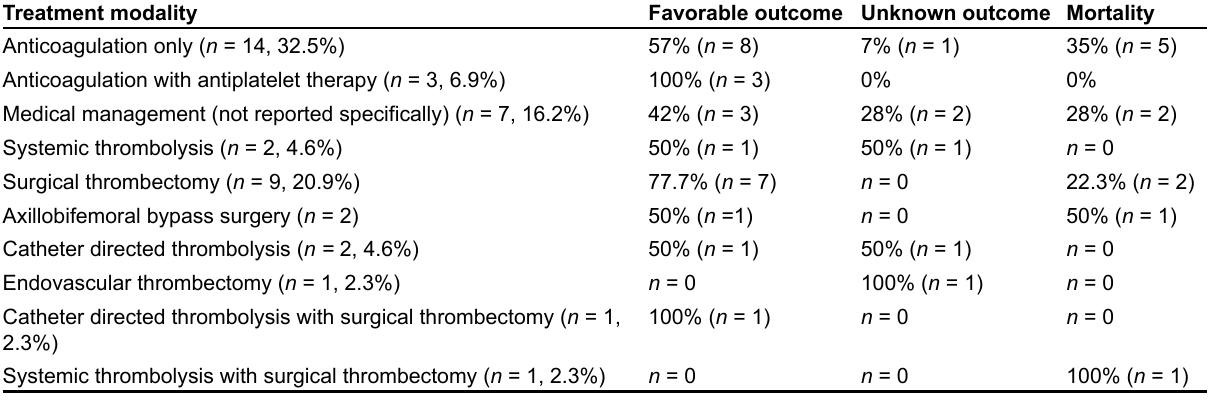
Table 1. Summary of various treatment modalities utilized for patients with COVID-19 infection complicated with aortic thrombus and overall